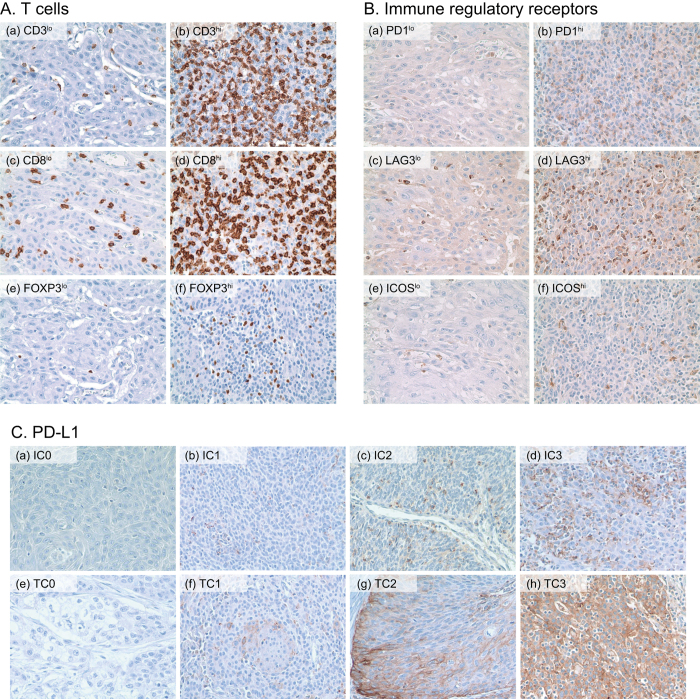
(A) A representative sample showing CD3+, CD8+, and regulatory T cells: (a) low infiltration of CD3+ T cells (b) high infiltration of CD3+ T cells (c) low infiltration of CD8+ T cells (d) high infiltration of CD8+ T cells (e) low infiltration of Foxp3+ Tregs (f) high infiltration of Foxp3+ Tregs. (B) A representative sample showing the expression of immune regulatory receptors on immune cells: (a) low expression of PD-1 (b) high expression of PD-1 (c) low expression of LAG-3 (d) high expression of LAG-3 (e) low expression of ICOS (f) high expression of ICOS. (C) PD-L1 expression was semi-quantitatively graded in tumor-infiltrating immune cells (IC) as IC0, 0% (a); IC1, >0% but <5% (b); IC2, ≥5% but <50% (c); and IC3 ≥50% (d). In tumor cells (TC), PD-L1 expression was graded as TC0, 0% (e); TC1, >0% but <5% (f); TC2, ≥5% but <50% (g); and TC3, ≥50% (h).